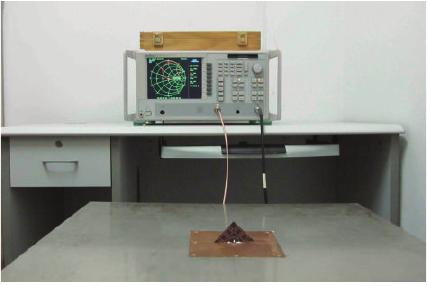
Figure 12: Measurement setup for the proposed antenna impe-